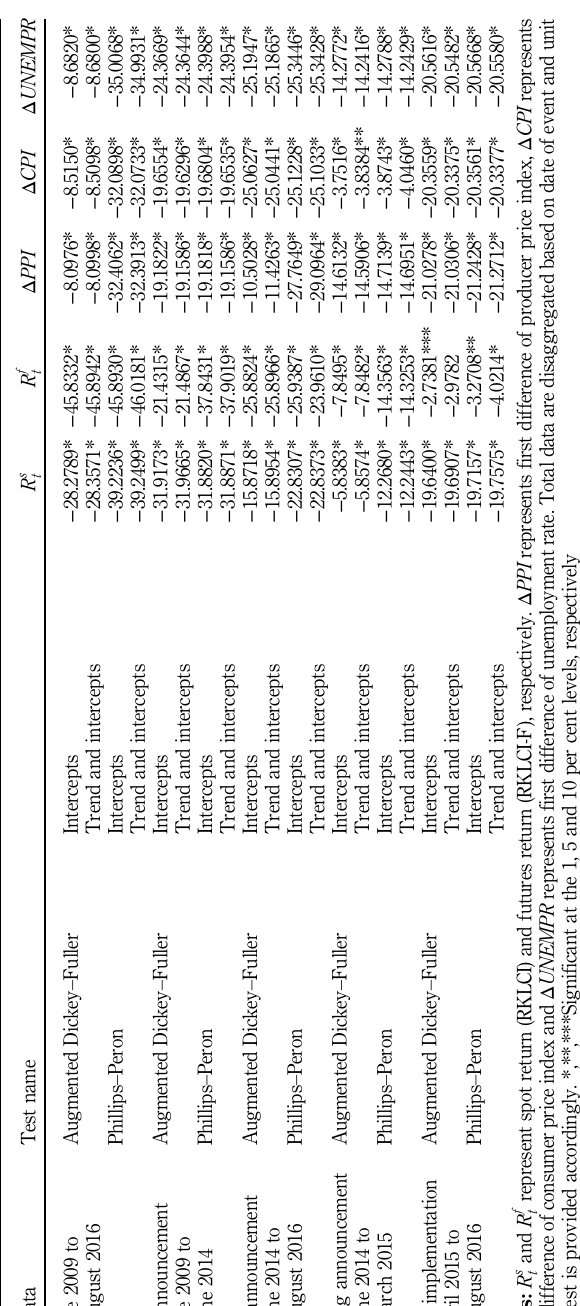
Table II. Unit root